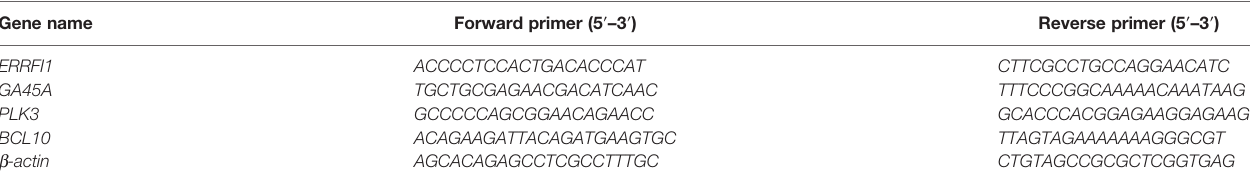
TABLE 1 | Primer sequences used in the